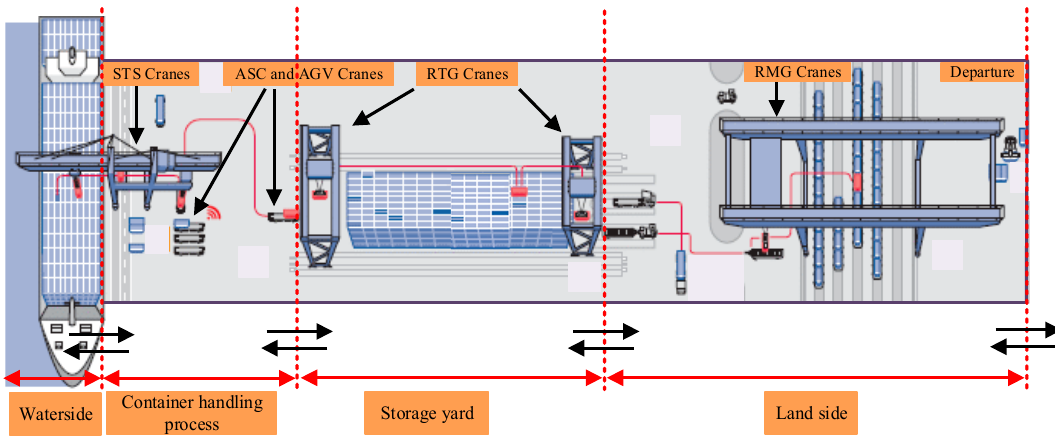
Figure 1. Flow diagram of a container terminal operation.